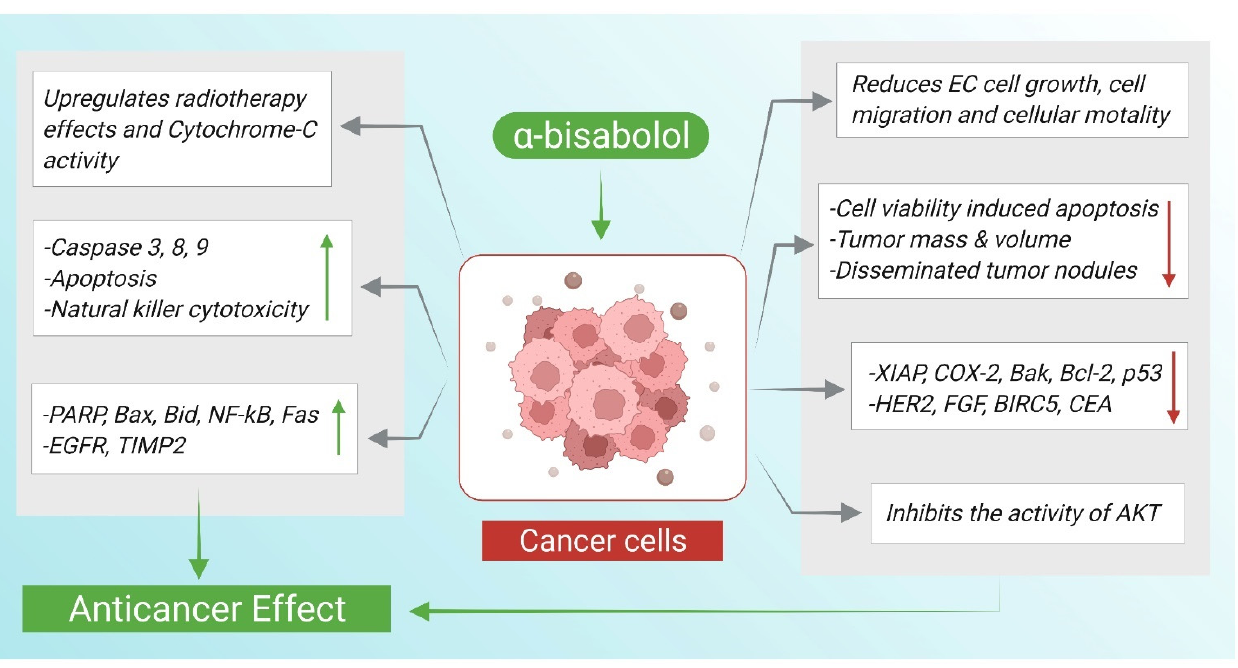
Figure 3. α -Bisabolol mediated anticancer actions and demonstrated mechanisms. ↑ ; increase, ↓ ;